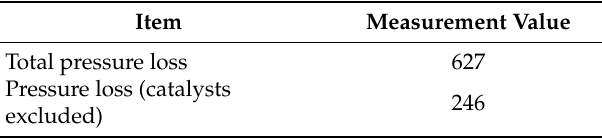
Table A3. Pressure loss in Experiment A1 (Pa).